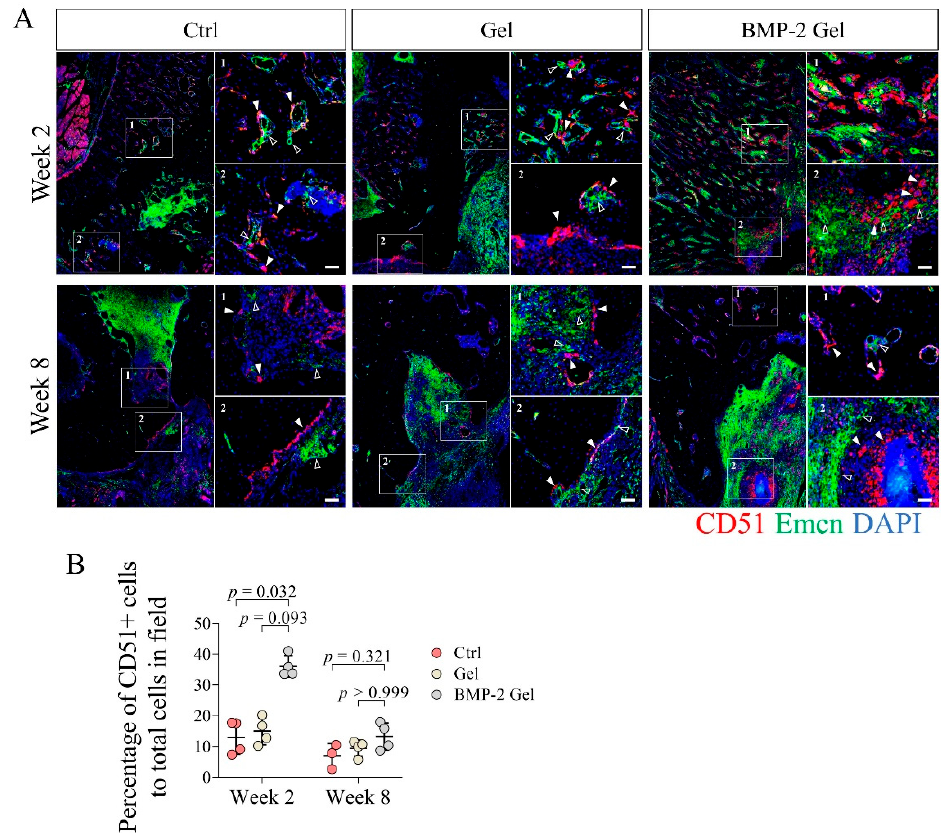
Figure 5. Implantation of BMP-2-loaded hydrogel facilitated the growth of CD51+ skeletal stem cells (SSCs) and their descendants during the bone regeneration of mandibular defects. ( A ) Immunofluo- rescent staining of CD51+ cells in the mandibular bone. Scale bar, 50 μ m. The white arrow indicates the CD51+ SSCs and descendants. The hollow arrow indicates the vessels. ( B ) Quantitative analysis of the number of CD51+ cells in the new bone. The p value was calculated by one-way ANOVA and Dunn’s multiple comparisons test.